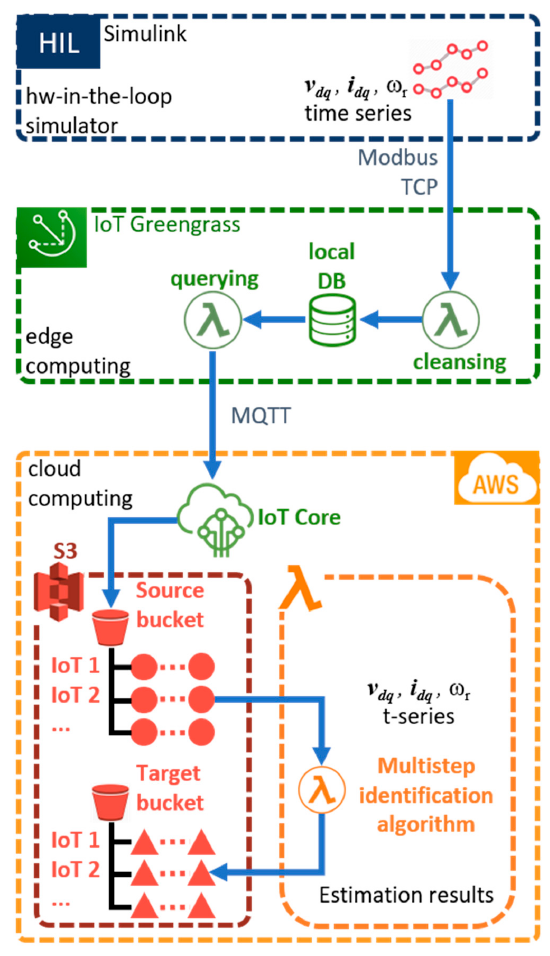
Figure 4. Multistep identification algorithm implemented in an AWS-based cloud prototype. Table 1. Motor and inverter parameters.